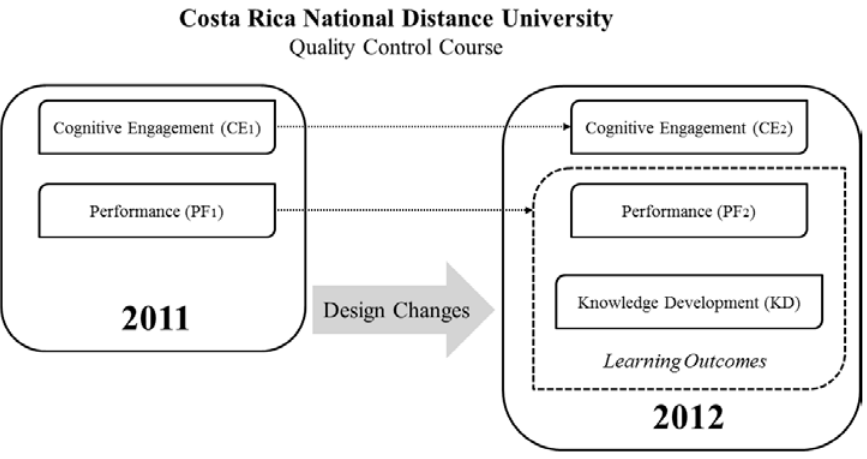
Figure 1 . Conceptual framework of the